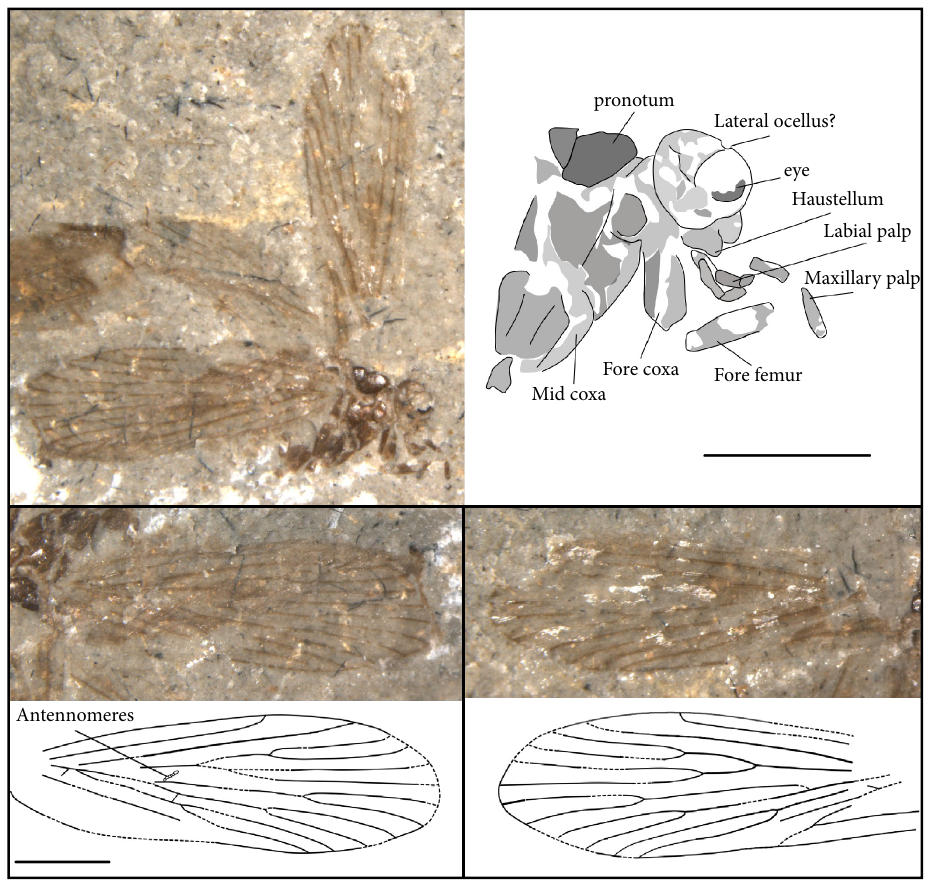
Figure 6: Holotype of Austaulius haustrum gen. et sp. nov. (NHMUK II 3103 a and b) from Monmouth Beach, Lyme Regis, Dorset. Bottom left figure is the right forewing of the holotype flipped so the costal margin is on top. Scale bars = 1 mm.